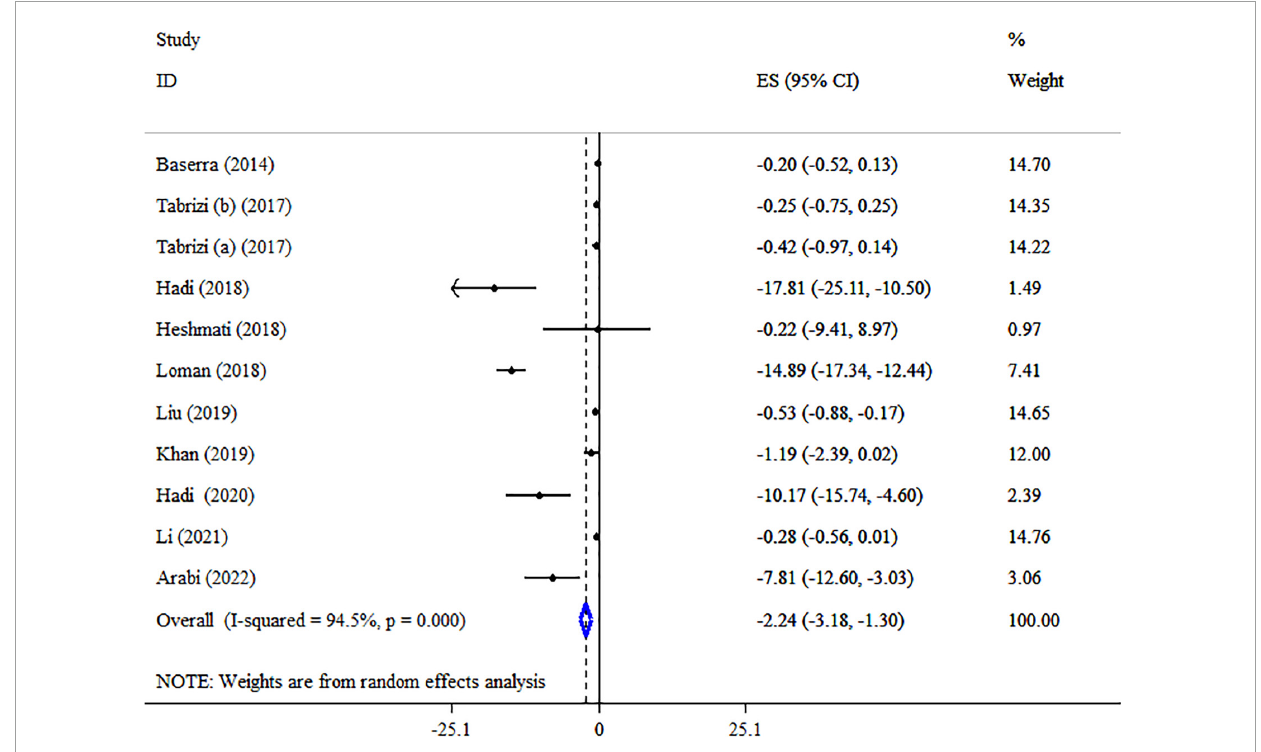
FIGURE6 Forest plot detailing mean difference and 95% confidence intervals (CIs), the impacts of synbiotic supplementation on TC levels.